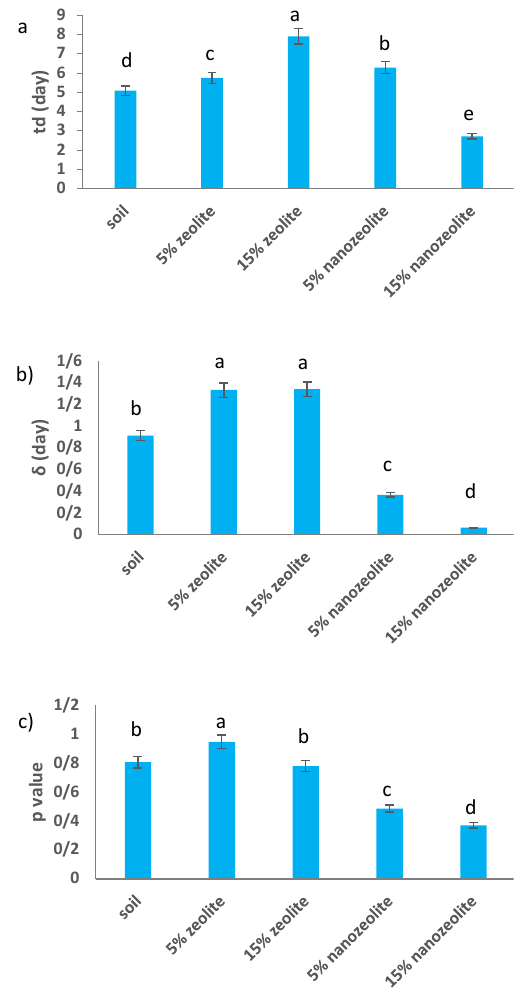
Fig. 4. The Weibull model parameters td (a), δ (b) and p (c) for E. coli NAR survival in the unsterile treatments. Bars are ± the Figure 4 : The Weibull model parameters td (a), δ (b) and p (c) for E. coli NAR standard deviation of means. Means followed by the same letter survival in the unsterile treatments. Bars are ± the standard deviation of means. on the columns indicates no significantly different (P<0.05) by Duncan’s multiple range Means followed by the same letter on the columns indicates no significantly different (P<0.05) by Duncan's multiple range tests.